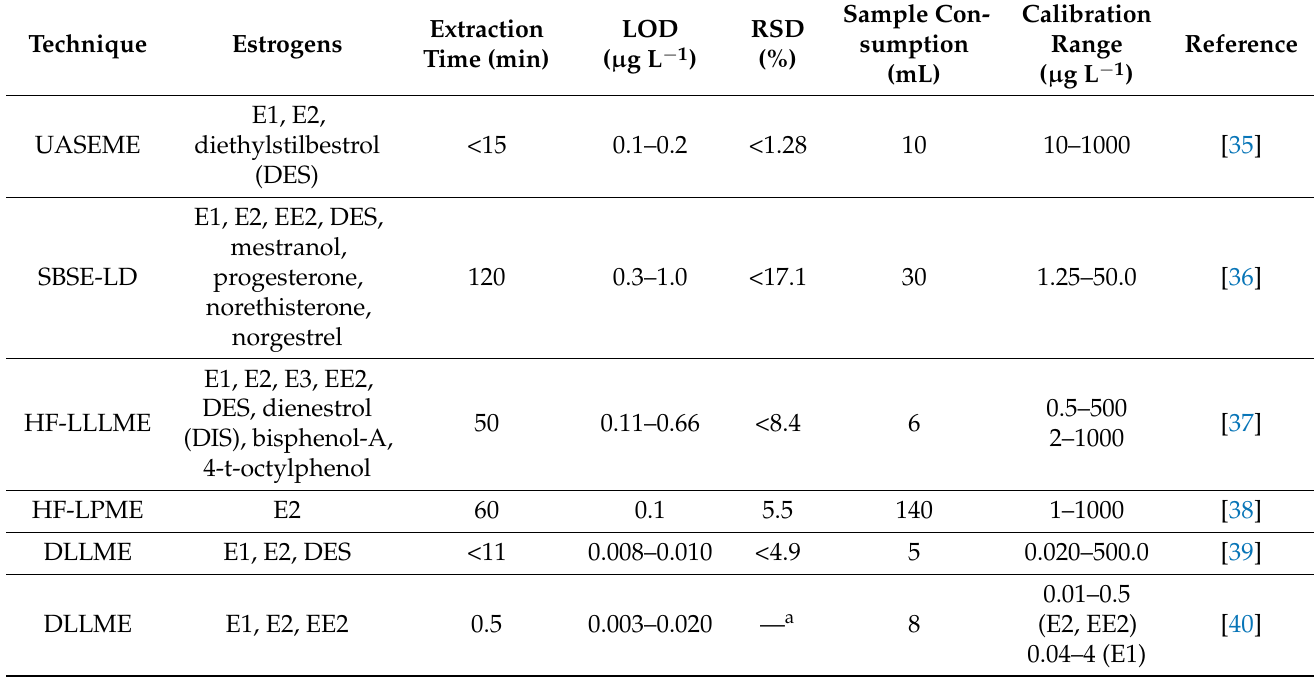
Table 3. Comparison of the proposed method with microextraction-based methodologies previously reported for the determination of estrogens in water samples prior to